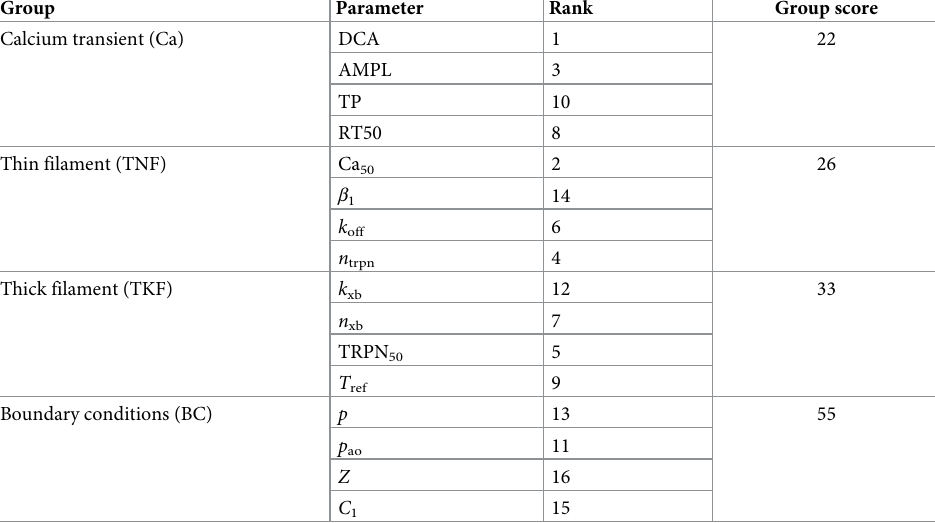
Table 3. Parameters ranking according to their influence on the model output total variance. A rank is assigned to each parameter according to how much it impacts the model output total variance. Parameter groups are assigned a score given by the sum of the ranks of their member parameters. This score reflects the importance of the group as an input for the multi-scale model.